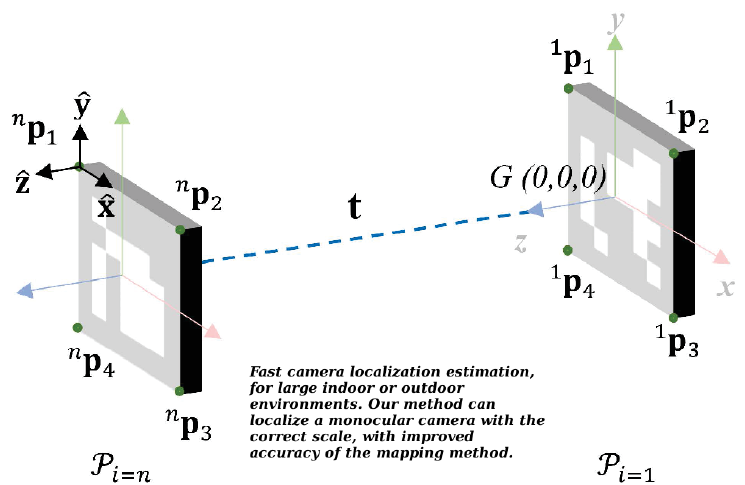
Figure 3. Process to compute P i for a marker set with n